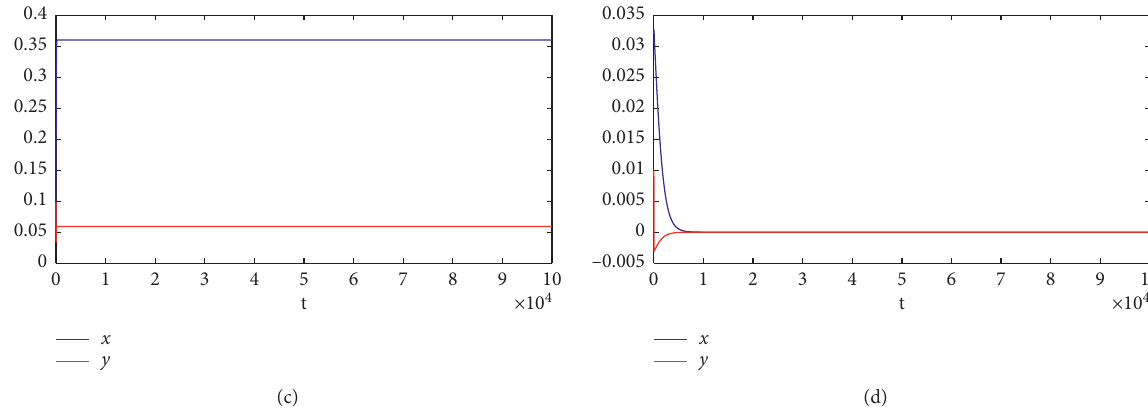
Figure 14: The mean-field approximation. (a) The system is stable when k k � 20 (b) and k � 30 (c) are in instability region. (d) The system is stable when k i i